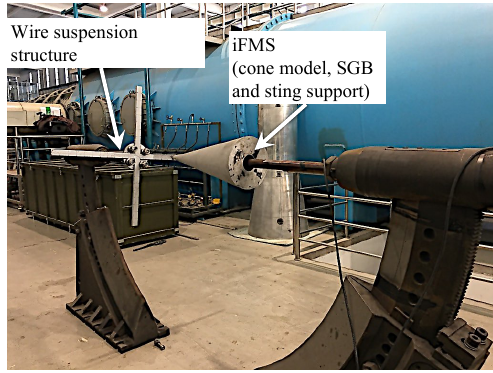
Figure 6. Photo of calibration device for SV-DSC.